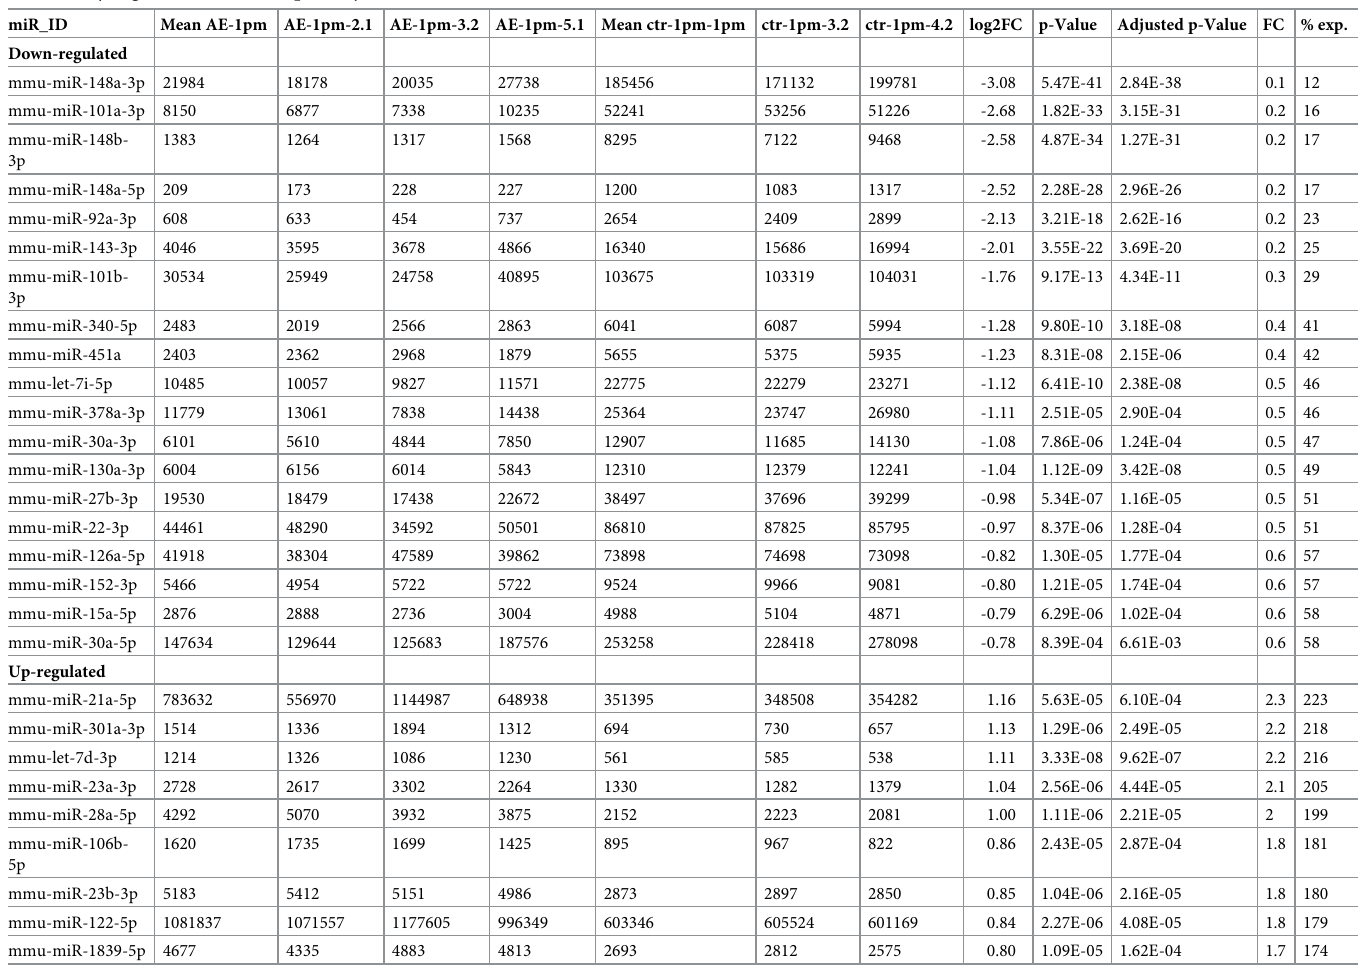
Table 2. Dysregulated miRNAs in primary AE.